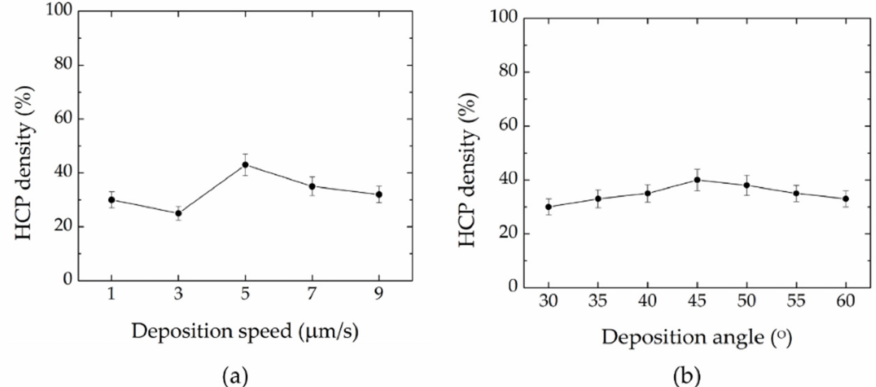
Figure 8. HCP density percentage of self-assembled PS films with: ( a ) varying deposition speeds and ( b ) varying deposition